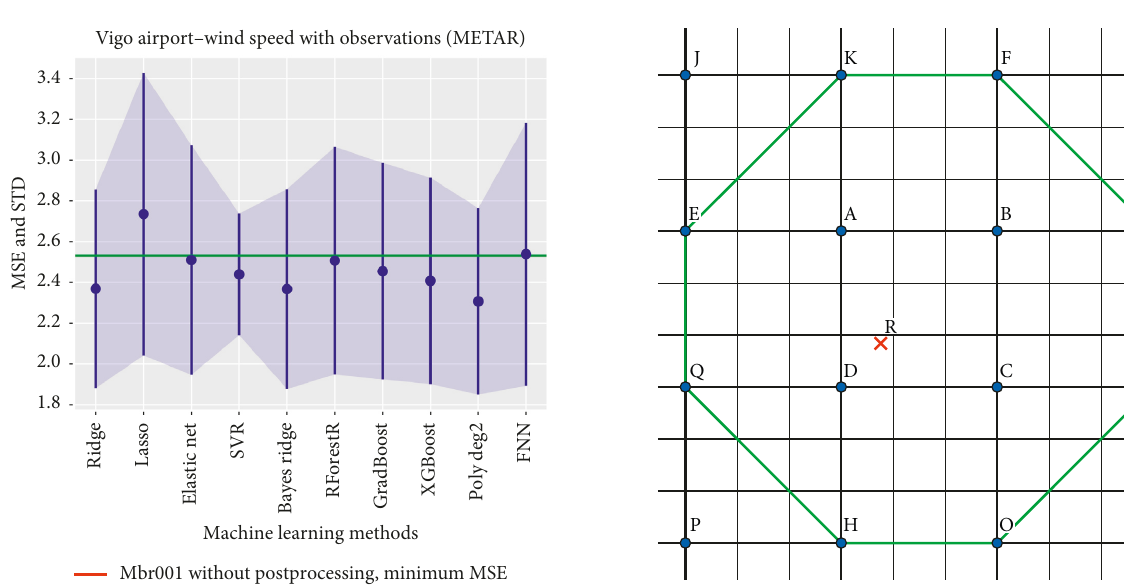
Figure 17: Irregular octagon representing the 12 points considered to calibrate the precipitation. The blue points are the grid points from the model, and the red point is the observation